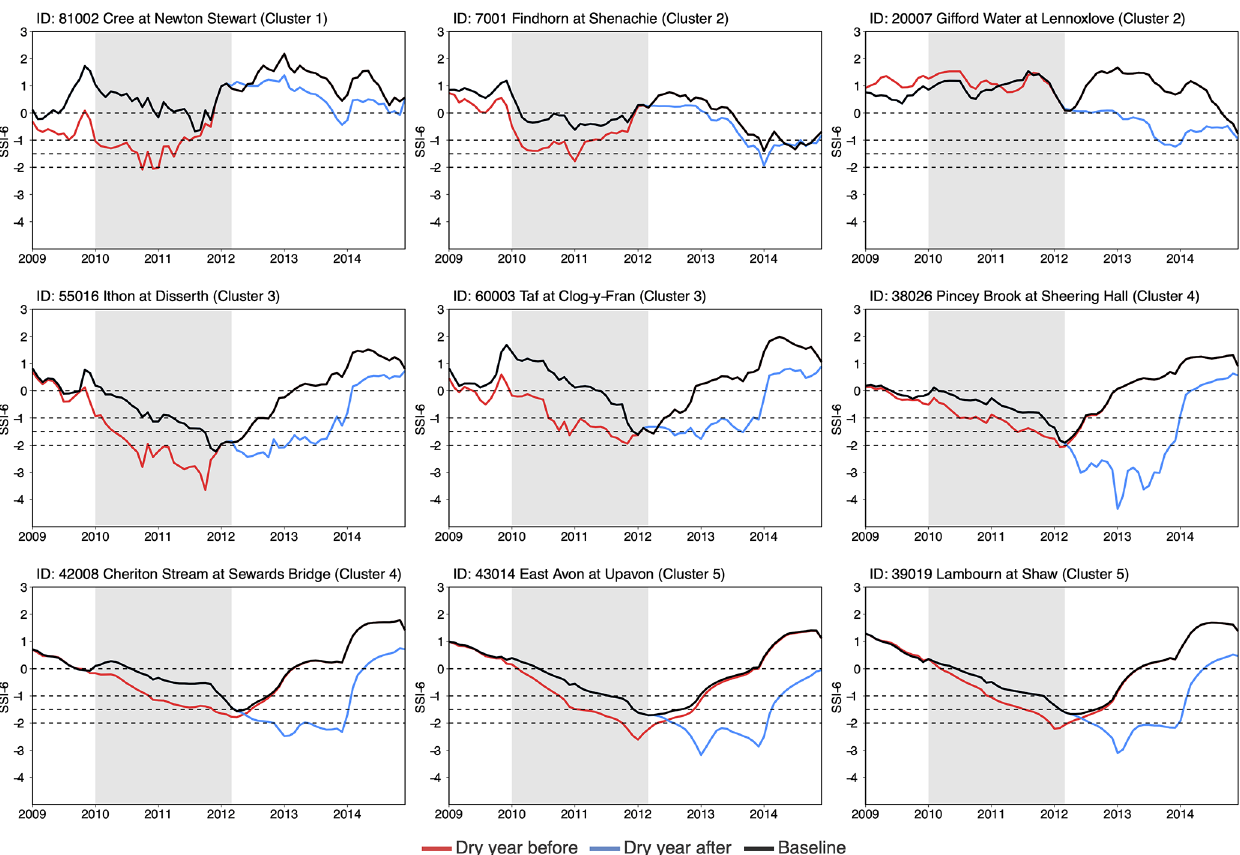
Figure 9. Baseline (black) and simulated SSI-6 for a repetition of a dry year before (red) or after (blue) the 2010–2012 drought for nine example catchments spanning the five hydrograph clusters. The shaded region indicates the duration of the baseline 2010–2012 drought event (January 2010 to March 2012). See Fig. S11 for the locations of the nine example catchments. See Figs. S8 and S9 for the SSI-12 and SSI-24.3.5 storylines of climate change.